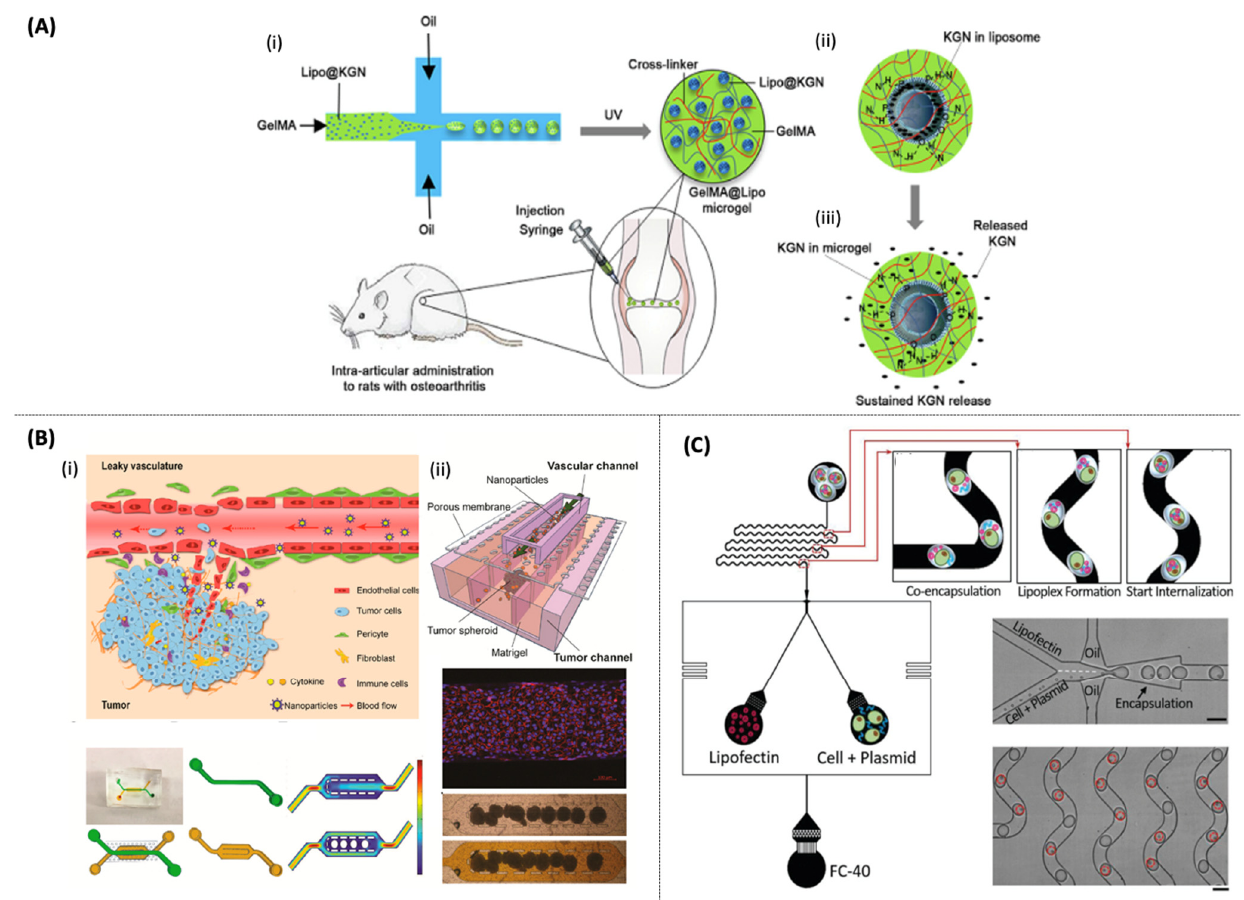
Figure 7. ( A ) (i, ii) Schematic illustration showing the (W/O) droplet-microfluidic fabrication of the KGN-loaded GelMA@Lipo hybrid microgel and its treatment in rat osteoarthritis via intraarticular injection. (iii) Schematic of the KGN release mechanism in GelMA@Lipo microgels [182]. ( B ) (i) Schematic of the in vivo tumor microenvironment consisting of a leaky vasculature and tumor tissues. (ii) Design and schematic illustration of a tumor-vasculature-on-a-chip (TVOC) [187] Scale bars: 100 μ m. ( C ) Droplet microfluidics-based single-cell lipofection platform [188] Scale bars: 100 μ m.